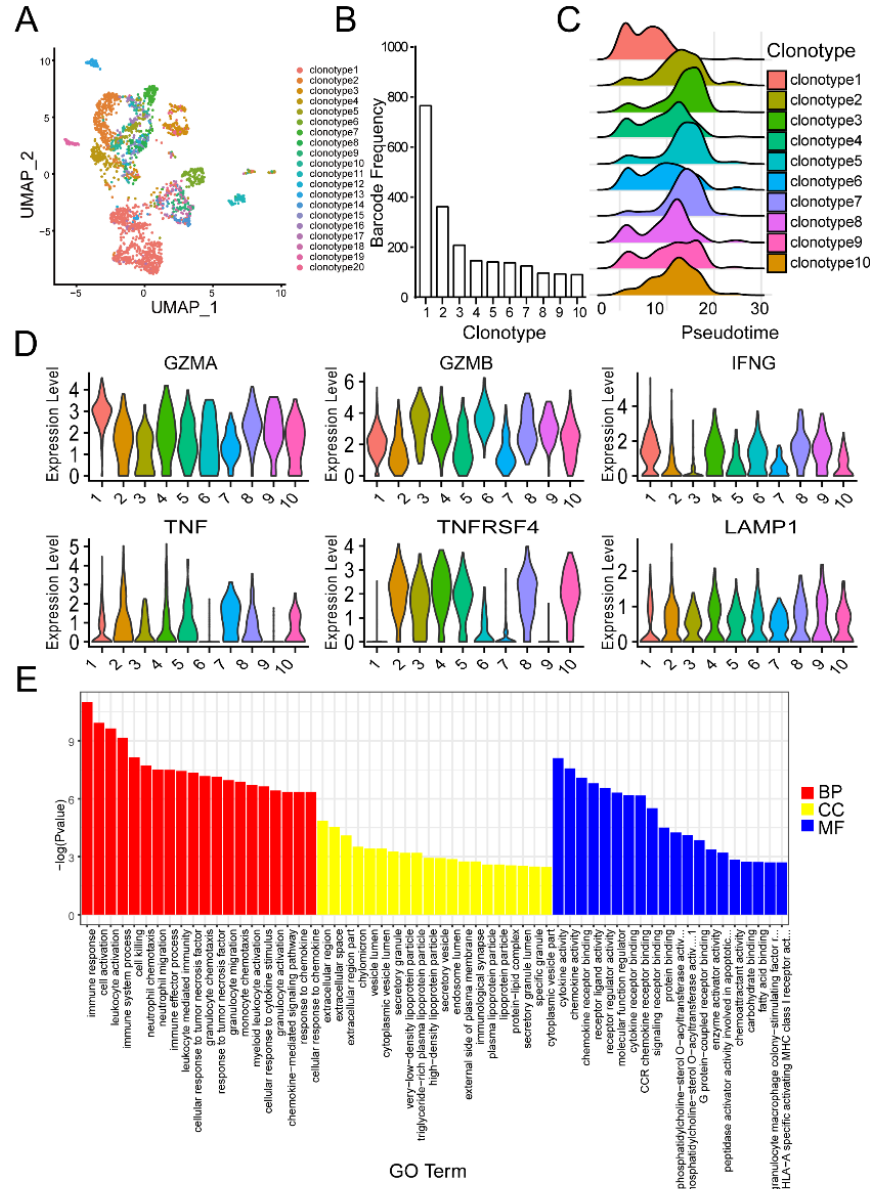
Figure 6. TCR coupled single cell RNA sequencing for DCs activated T cells. UMAP for TCR coupled single cell RNA sequencing showing top 20 clonotypes after activation by DCs ( A ); graph for top 10 clonotypes frequency ( B ); pseudotime analysis for top 10 clonotypes ( C ); representative inflammatory cytokines expression in top 10 clonotypes ( D ); GO analysis showing the enriched pathways in biological process (BP), cellular component (CC) and molecular function (MF) ( E ). 3.6. T Cells Activated by EDA-E7 Matured DCs Efficiently Kills HPV16E7 Infected